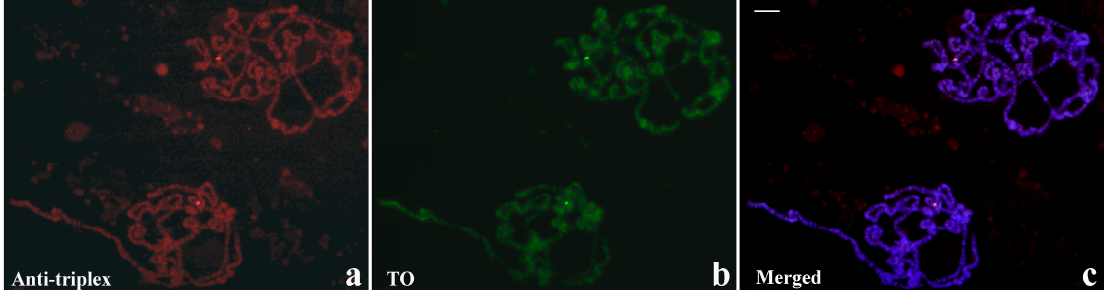
Figure 10. Simultaneous detection of anti-triplex and TO staining in polytene chromosomes from y/w/bw D ( bw D ) larva. Antibody labelling ( a , Anti-triplex), TO staining ( b , TO) and merged signals of antibody, TO and DAPI staining ( c , Merged). The brightest signals fall in a single section of the polytene complement showing the overlap by TO and immunocytochemical labelling. Scale bar corresponds to 40 µ m.